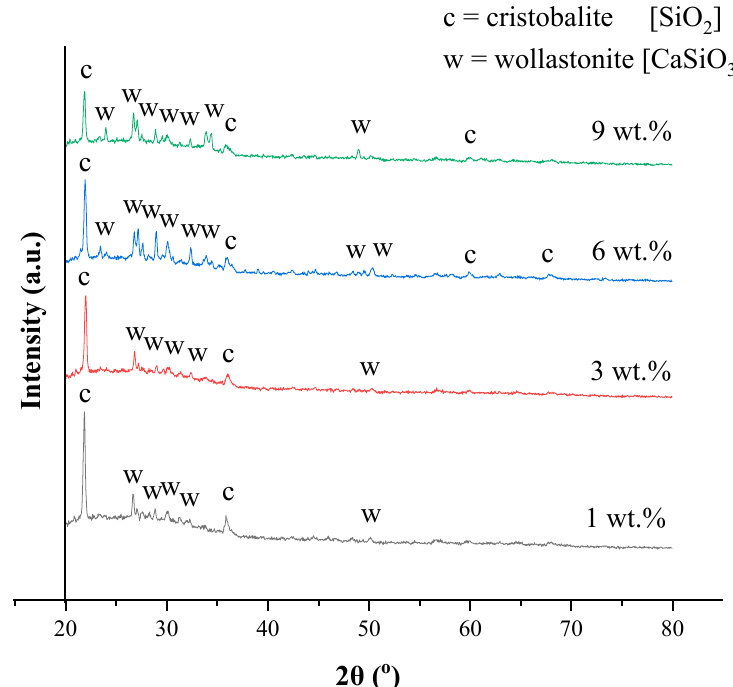
Figure 8. XRD pattern at different content of ES with a reference peak of wollastonite (CaSiO 3 , 96-900–